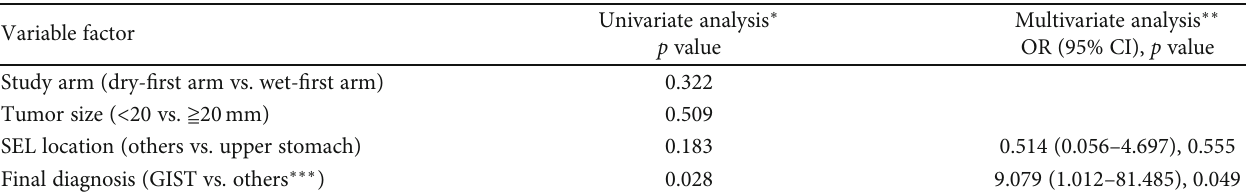
Table 4: Univariate and multivariate analyses of factors in fl uencing the moderate and high cellularity of EUS-FNA specimens. (a) Analysis of the specimen cellularity obtained by DRY